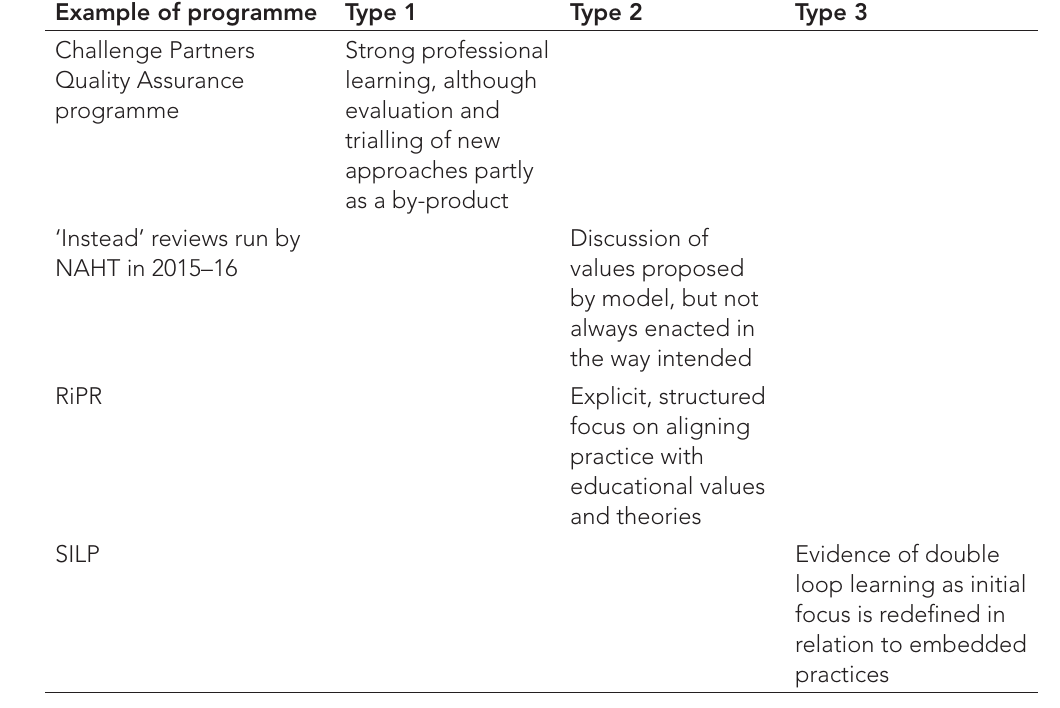
Table 2: Summary of analysis from four peer review programmes and their ‘fit’ to the action research typology found in Foreman-Peck and Murray (2008) Example of